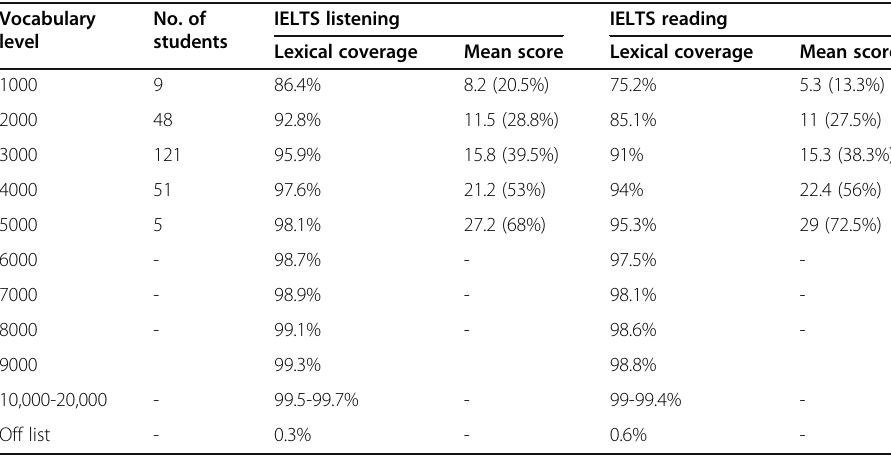
Table 5 Relationship between the LVLT score, lexical coverage, listening and reading comprehension